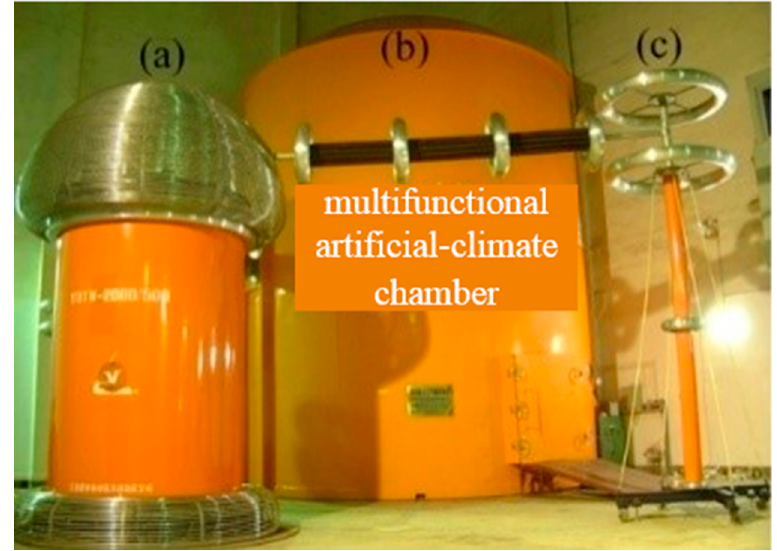
Figure 1. Experimental facilities ( a ) 500 kV/2000 kVA testing transformer; ( b ) multifunctional artificial ‐ climate chamber; ( c ) 500 kV capacitive voltage divider.